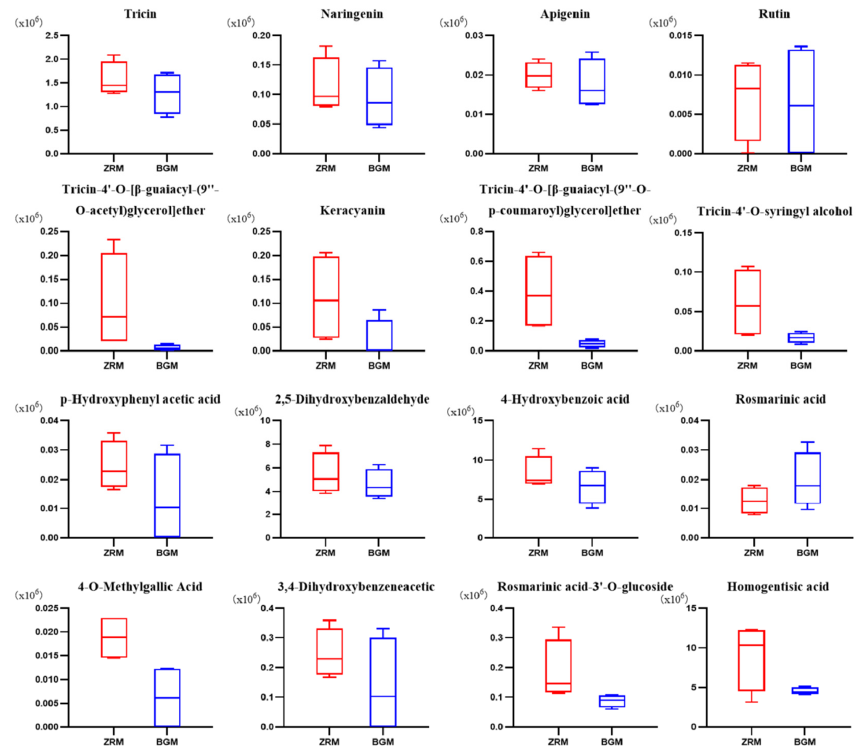
Figure 4. Boxplot of flavonoids and phenolic acids in P. amarus bamboo shoots grown under shading treatment and normal growing conditions. Y-axis represents the peak surface of each metabolite. BGM: shading group, ZRM: control group. Flavonoids: tricin, naringenin, apigenin, rutin, tricin-4 ′ -O-syringyl alcohol, tricin-4 ′ -O-[ β -guaiacyl-(9 ″ -O-acetyl)glycerol]ether, cyanidin-3-O-rutinoside, and tricin-4 ′ -O-[ β -guaiacyl-(9 ″ -O-p-coumaroyl)glycerol]ether. Phenolic acids: 4-hydroxyphenylacetic acid, 2,5-dihydroxybenzaldehyde, p-hydroxybenzoic acid, rosmarinic acid, 3,4-dihydroxyphenylacetic acid, homogentisic acid, 4-O-methylgallic acid, and rosmarinic acid-3 ′ -O-glucoside. 3.6. Changes in the Phenolic Acid Contents of P. amarus Bamboo Shoots Grown under Shading Treatment